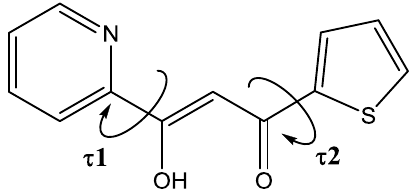
Figure 1. Molecular conformation.